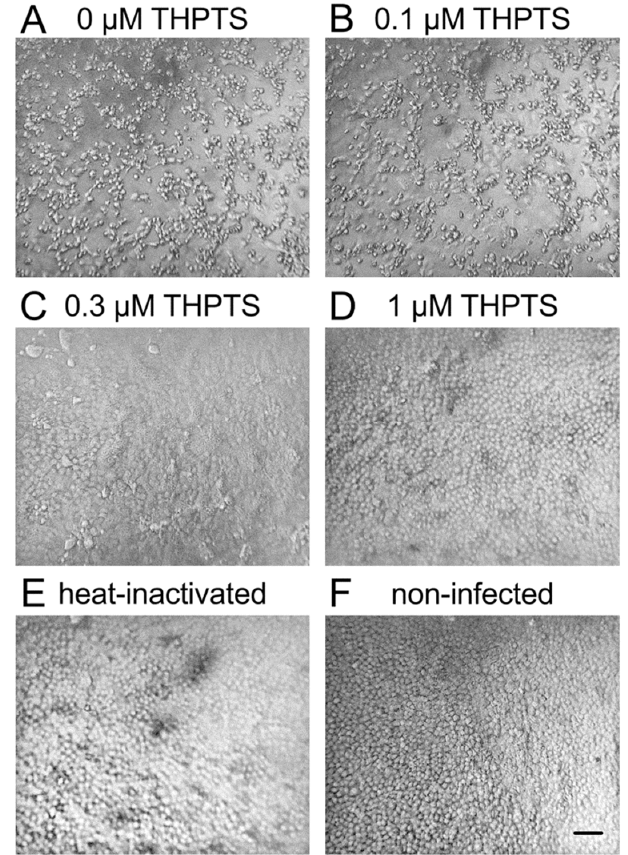
Figure 1. Viral cytopathic effects after infection of Vero E6 cells with PDI-treated SARS-CoV-2. Six days after infection, cell cultures showed clear signs of viral cytopathic effects (CPE) when photodynamic inactivation (PDI) of SARS-CoV-2 was performed for 10 min (light dose 7.8 J/cm 2 ) without the photosensitizer THPTS prior to infection ( A ). With THPTS at indicated concentrations ( B – D ), the PDI of SARS-Cov-2 prevented subsequent infection and, therefore, CPE in a concentration- dependent manner. At 1 µ M THPTS ( D ), cell cultures were free from signs of viral infection and very similar to those after infection with heat-inactivated SARS-CoV-2 ( E ) and those without infection ( F ). Scale bar indicates 100 µ